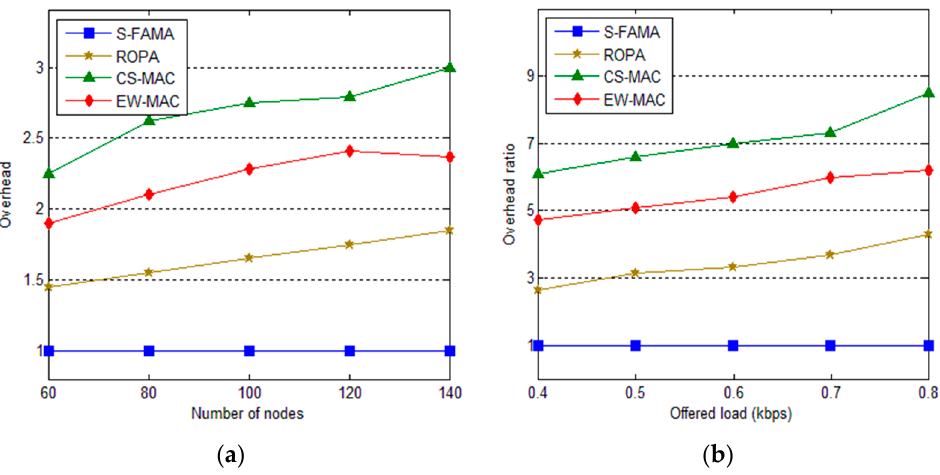
Figure 10. Overhead in different network situations. ( a )The overhead of protocols spend for the number of sensors within range (60, 140) while offered load is 0.5kbps; ( b )The overhead ratio of protocols according to the offered load within range (0.4, 0.8) kbps among 200 sensors.